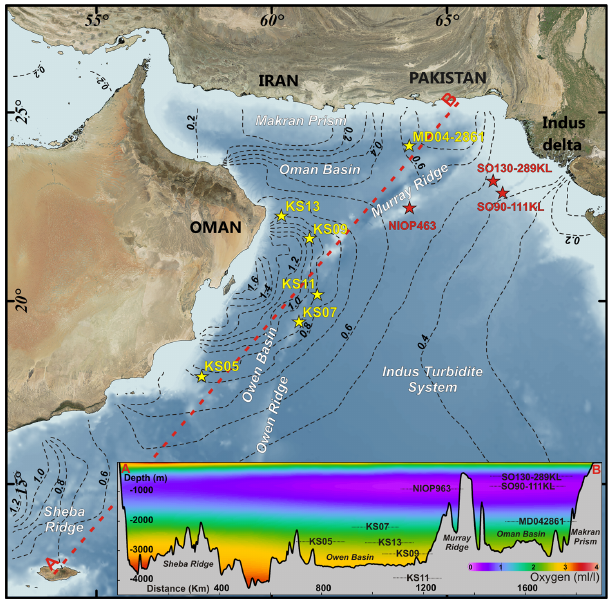
Fig. 1. Core locations in the Arabian Sea with hydrological data corresponding to Indian summer monsoon conditions. The effect of summer monsoon wind-driven upwelling of nutrient-rich subsur- face waters is visible through the surface concentration in chloro- phyll (black dash lines in µgL − 1 ; data from July, August, Septem- ber derived from NOAA NODC WOA01; Conkright and Boyer, 2002). Low supply of oxygen by physical pump, combined with high surface productivity, produces an intense oxygen minimum zone (OMZ) (data for the oxygen profile are derived from the WAO05 (Garcia et al., 2006) and plot using Ocean Data View (Schlitzer, 2011)) as visible along the A–B profile. Yellow and red stars indicate the coring sites used in this study and previously pub- lished (Schulz et al., 1998; Ziegler et al., 2010; Deplazes et al., 2013),